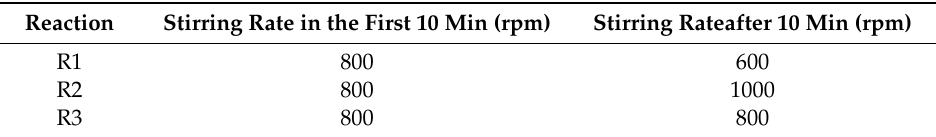
Table 4. Agitation speeds in the different reaction